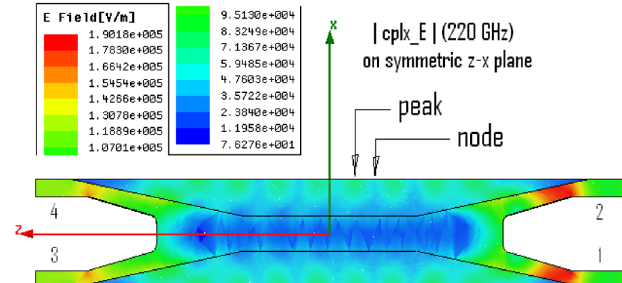
FIG. 20. (Color) Contour of amplitude of complex electric field on the symmetric z - x plane. The fields are excited at port-1 and port-2 simultaneously with 1 W = port